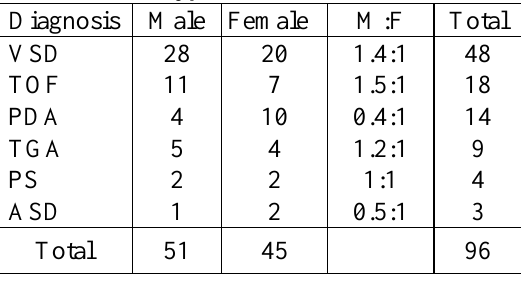
Table 1: Various types & percent of Table 2: Sex distribution of Various